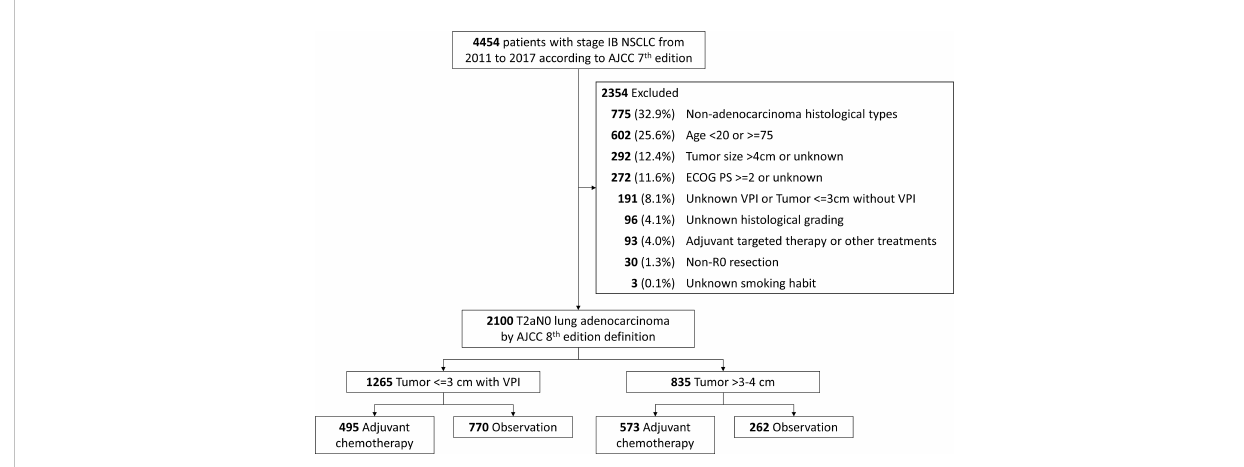
FIGURE 1 Algorithm for inclusion of study participants. Abbreviations: NSCLC, non-small-cell lung carcinoma; ECOG PS, Eastern Cooperative Oncology Group Performance Status; AJCC, American Joint Committee on Cancer; VPI, visceral pleura